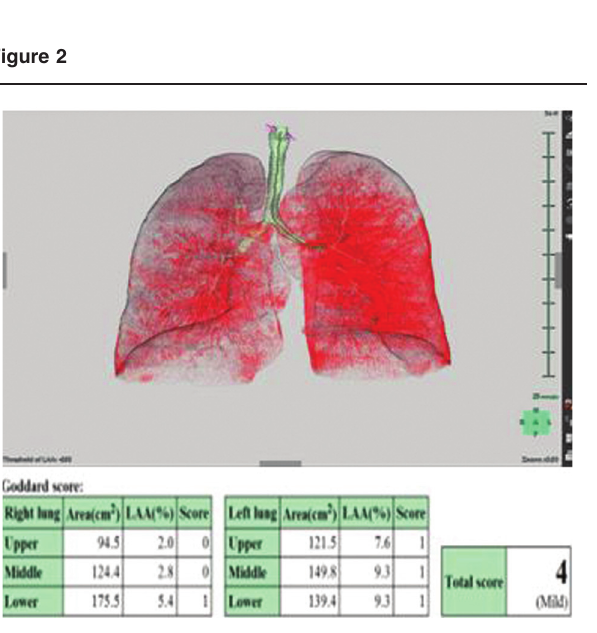
The same patient with computed tomography densitometry showing automated red coloring of the low-attenuation area (LAA) less than − 950 HU. Each area of the LAA is defined as a cluster. The percent- age of LAA per surface area can be calculated. The table at the bottom of the image shows Goddard score calculation. In this patient, the Goddard score was 4 (mild), and this was consistent with the spirometric results classified as GOLD I.